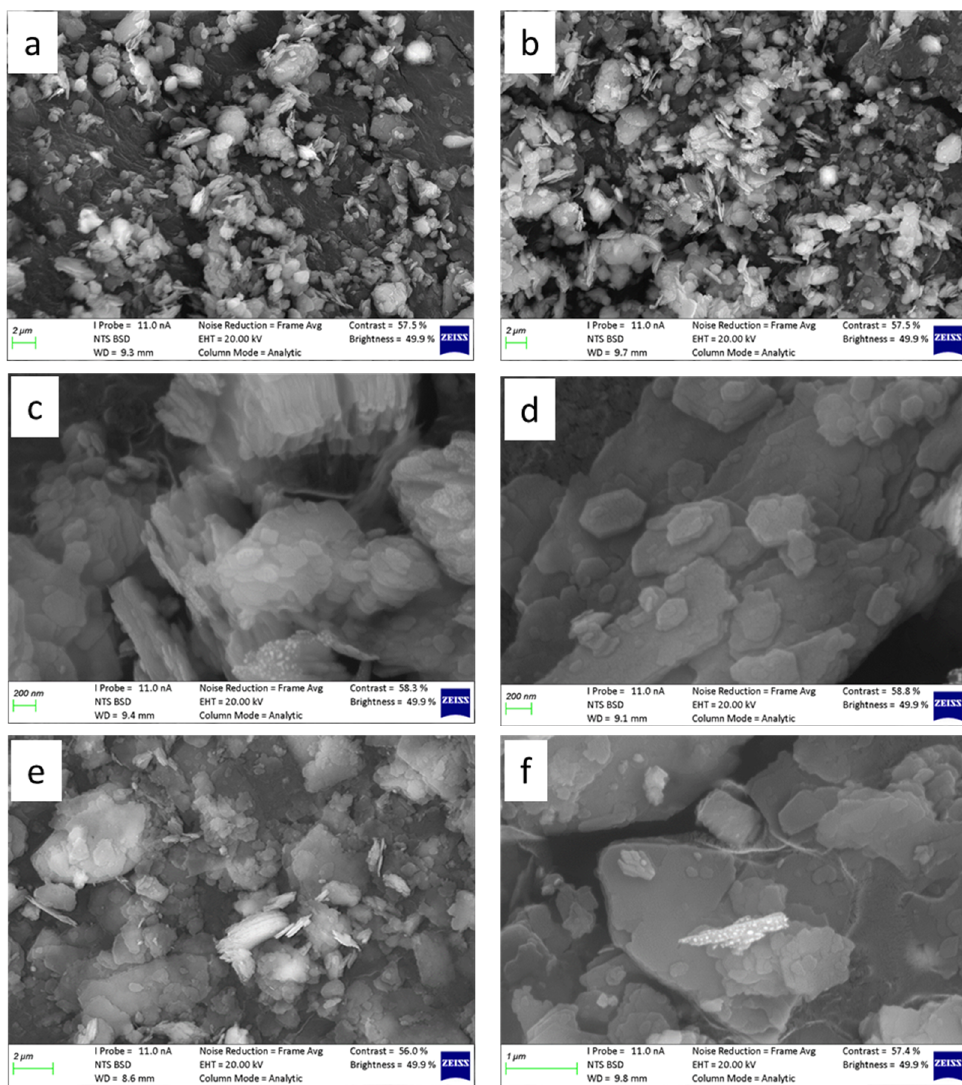
Figure 6. Scanning electron microscopy (SEM) micrographs of: Eruku ( a ) and Lakiri ( b ) kaolins showing platy particles, Awo-Omama ( c , d ) pseudohexagonal stacks and books with euhedral crystals, and Ubulu-Uku ( e , f ) kaolins showing pseudohexagonal stacks and books with subhedral crystals.